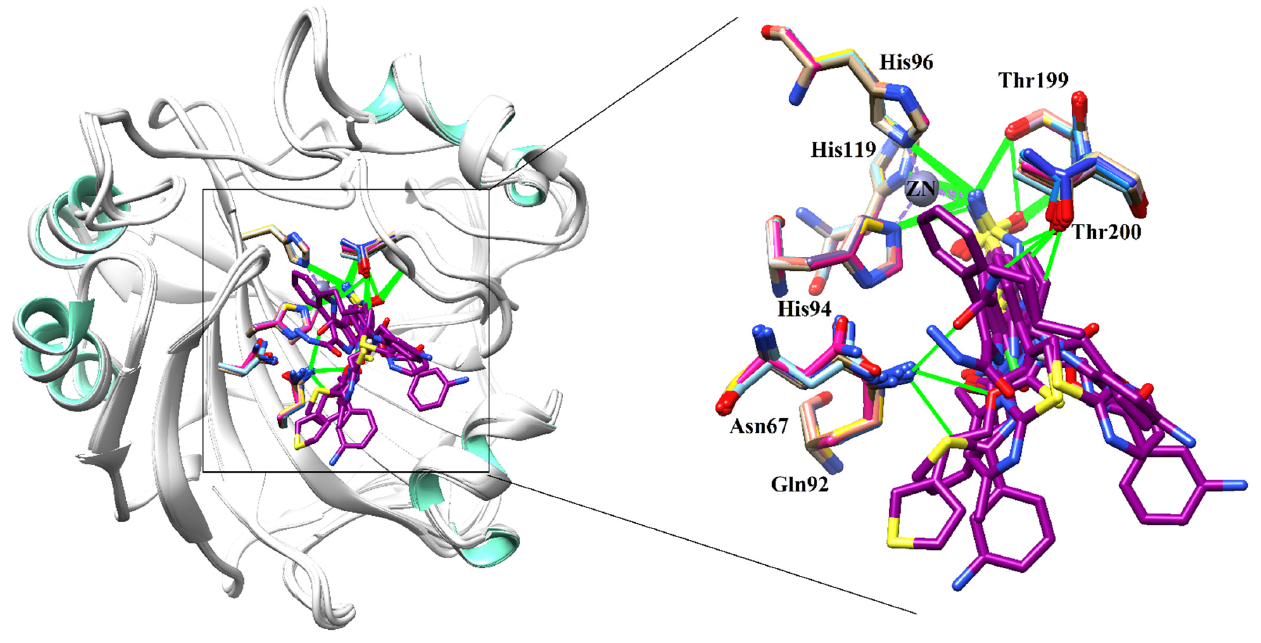
Figure 1. The superimposed conformations of several 3D-Structure of Human CA-II are shown in complex with their cognate ligands (PDB codes: 2FOU, 3B4F, 3HS4, 3K34, 4FPT, 4IZW, 4KNI, 4KNJ, 5BYI, 6G6T, 6S6G, and 7JNR). The ligands are presented in magenta stick model, and H-bonds are depicted in green lines.